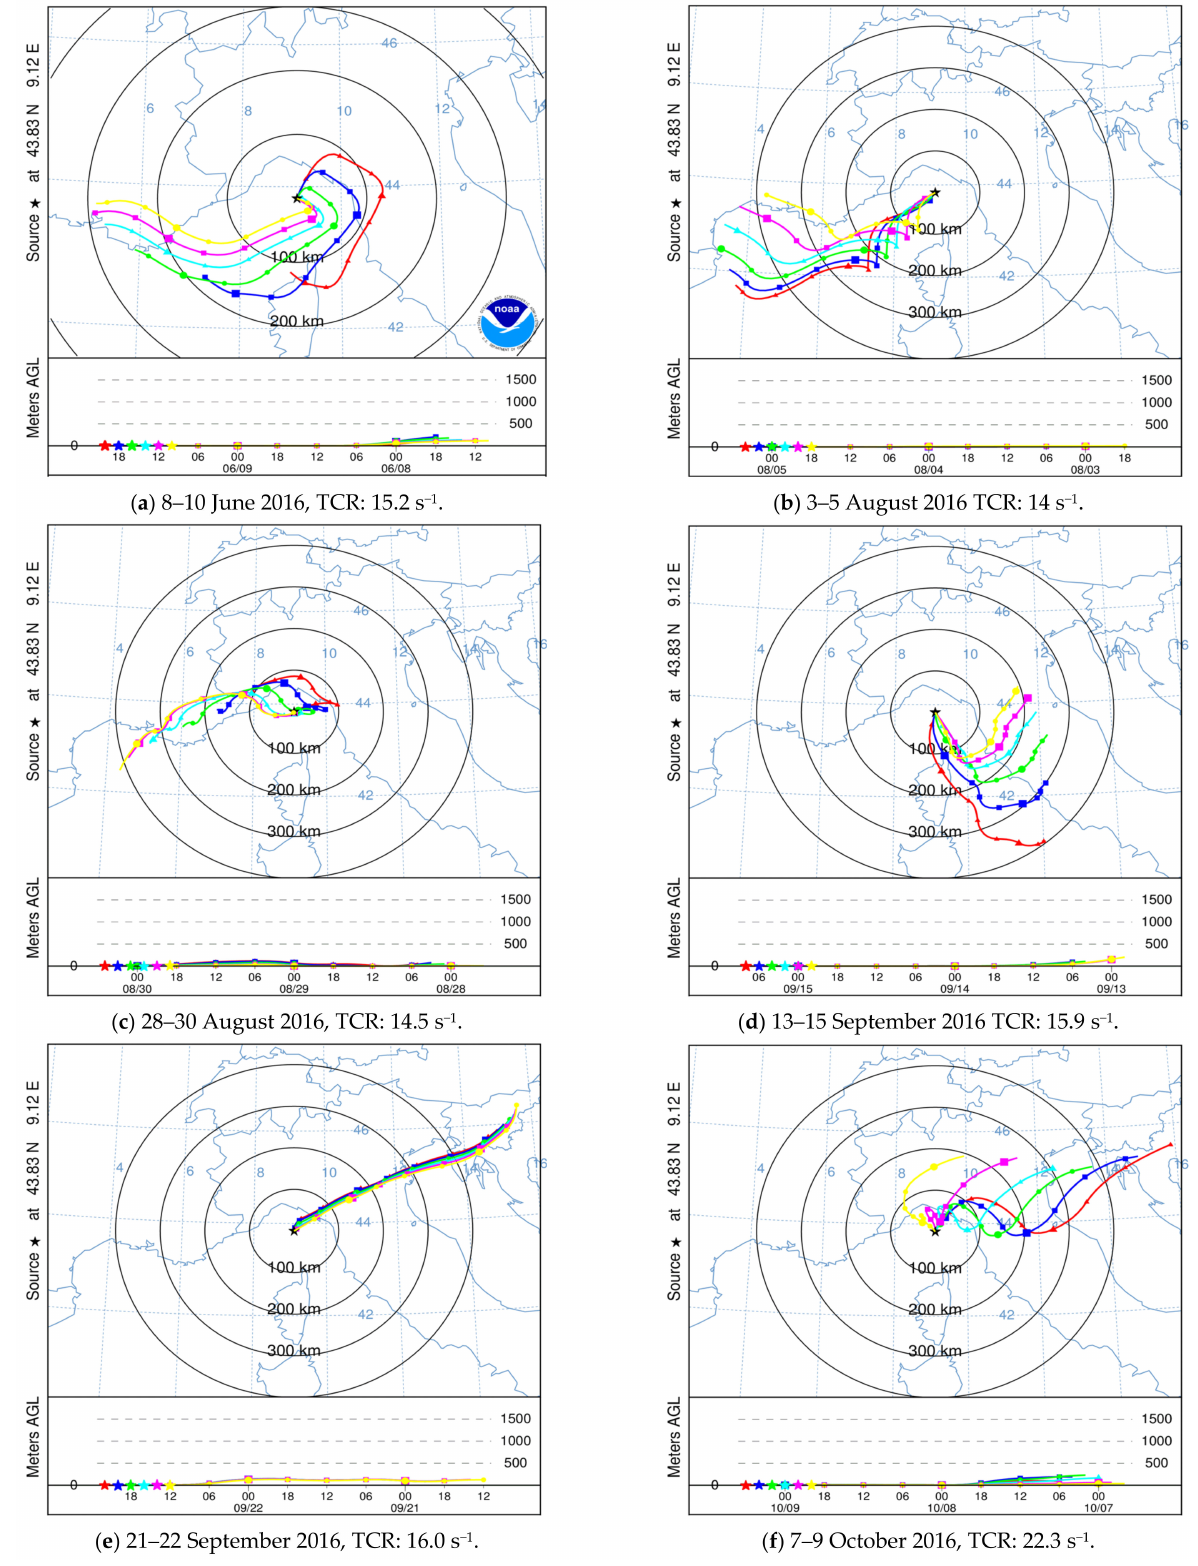
Figure 7. Back-trajectories obtained with the HYSPLIT model using NCEP/NCAR global reanalysis meteorological fields computed at 0 m above the ground level (AGL) and runtime of 48 h for rainy events occurred in June, August, September and October 2016. Different colors indicate 48 h periods starting 0 h (red), 2 h (blue), 4 h (green), 6 h (cyan), 8 h (magenta) and 10 h (yellow) before the rain